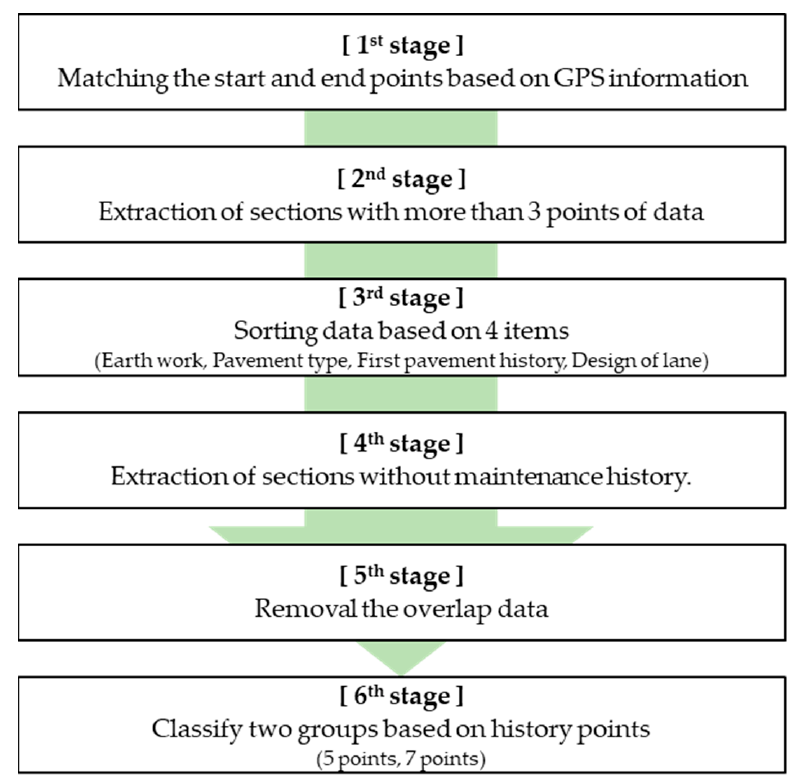
Figure 2. Flow chart of data pre-processing in six stages.